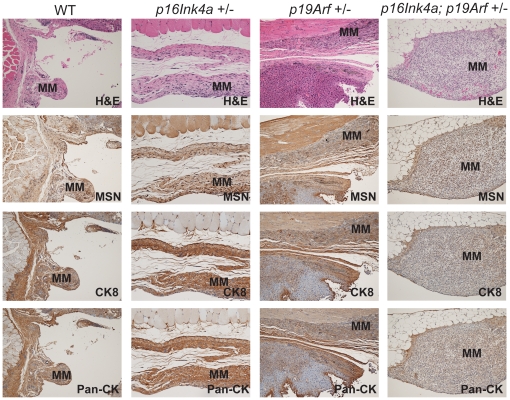
Representative histopathology of asbestos-induced MMs.Sections were stained with hematoxylin and eosin (H&E) or with antibodies against mesothelin (MSN), cytokeratin (CK8), and pan-cytokeratin (Pan-CK).